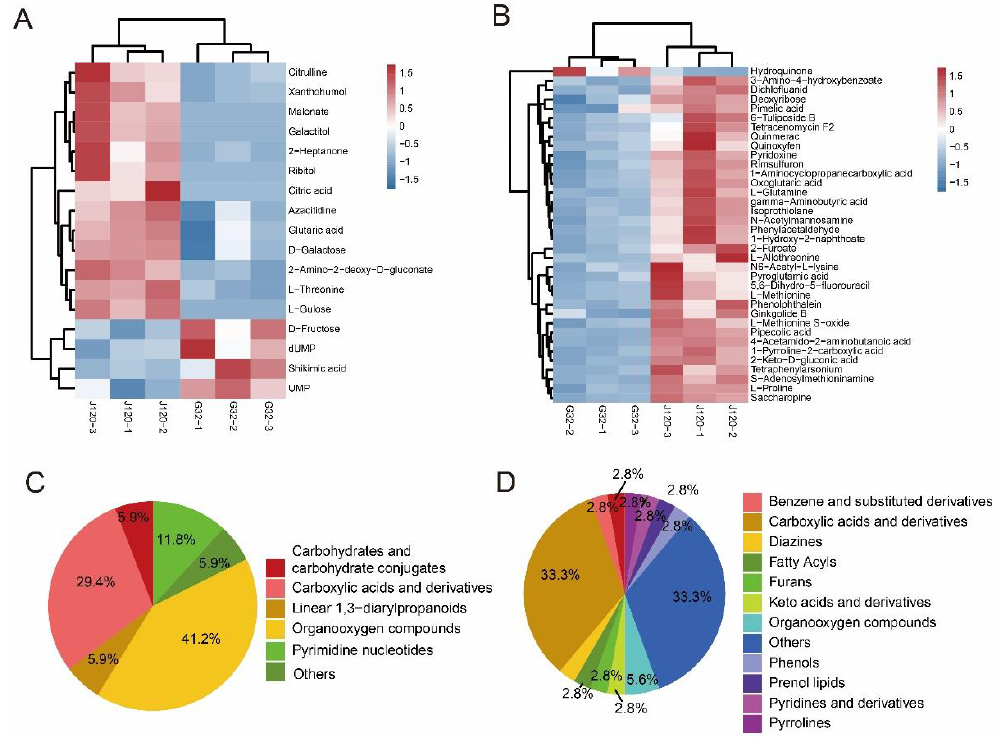
Figure 3. Differentially accumulating metabolites between “G32” and “J120.” ( A ) and ( B ): identified differen tial metabolites in “J120” compared to “G32” in negative ionization (NEG) and positive ionization (POS) modes, respectively. ( C ) and ( D ): pie chart of the differential metabolites identified between “G32” and “J120” .